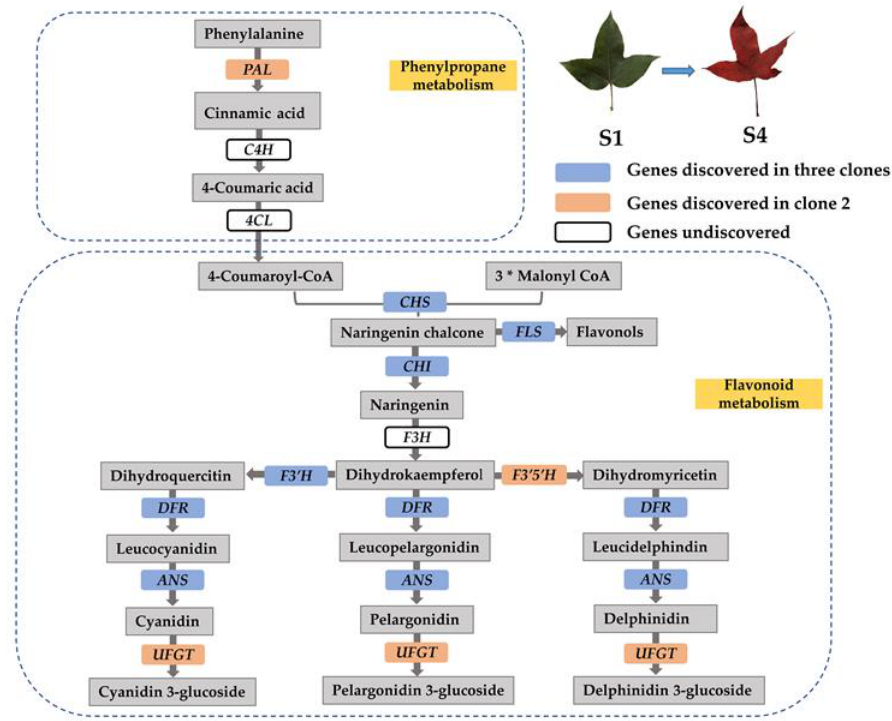
Figure 6. Schematic representation of the anthocyanin biosynthetic pathway. PAL, phenylalanine ammonia lyase; C4H, cinnamate-4-hydroxylase; 4CL, 4-coumaroyl-coA synthase; CHS, chalcone synthase; CHI, chalcone isomerase; F3H, flavanone 3-hydroxylase; F3 (cid:48) H, flavonoid 3 (cid:48) -hydroxylase; F3 (cid:48) 5 (cid:48) H, flavonoid 3 (cid:48) ,5 (cid:48) -hydroxylase; DFR, dihydroflavonol 4-reductase; ANS, anthocyanidin synthase; UFGT, flavonoid 3-O-glucosyltransferase; FLS, flavonol synthase. The “*” means tion.